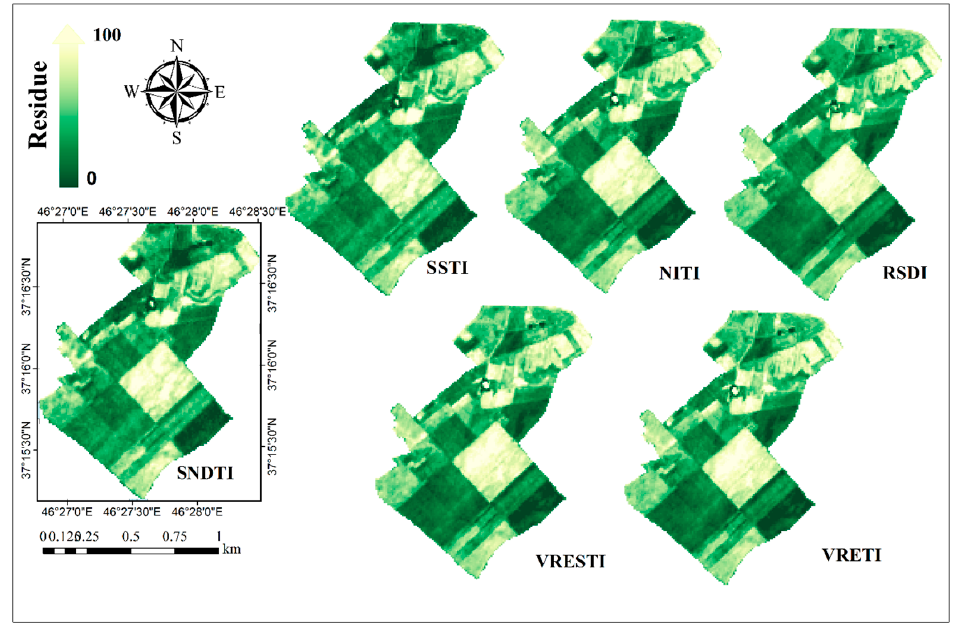
Figure 7. SSR maps of the Sentinel-2A-based indices.